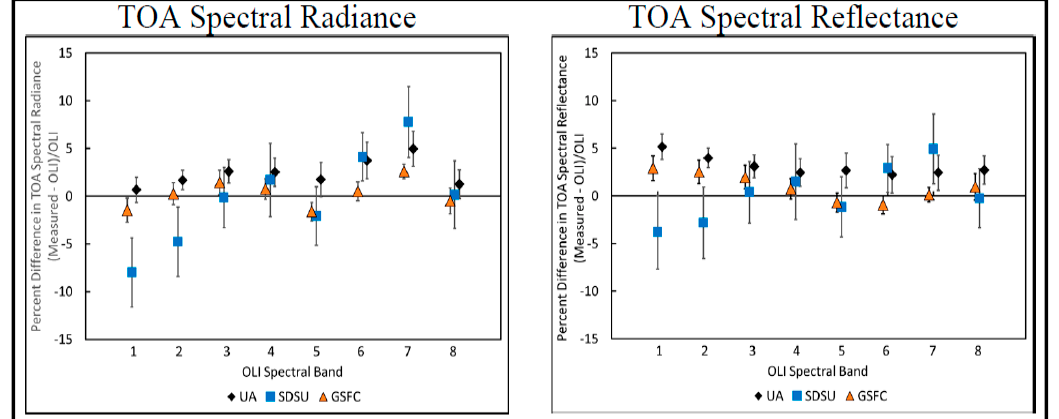
Figure 5. Percentage difference [82] ( a ) TOA spectral radiance ( b ) TOA spectral reflectance.